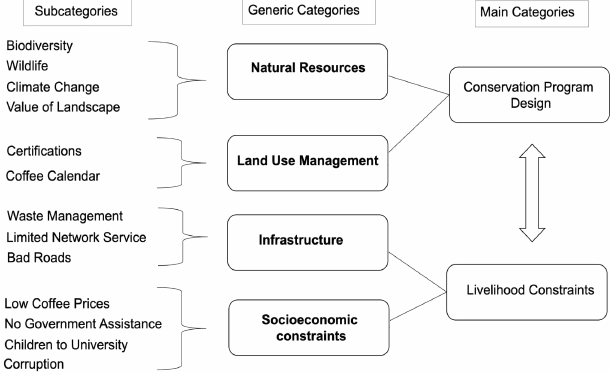
Fig. 3 . Results of the qualitative content analysis, expressed as a flow chart of subcategories, generic categories, and main categories based on responses from the five focus